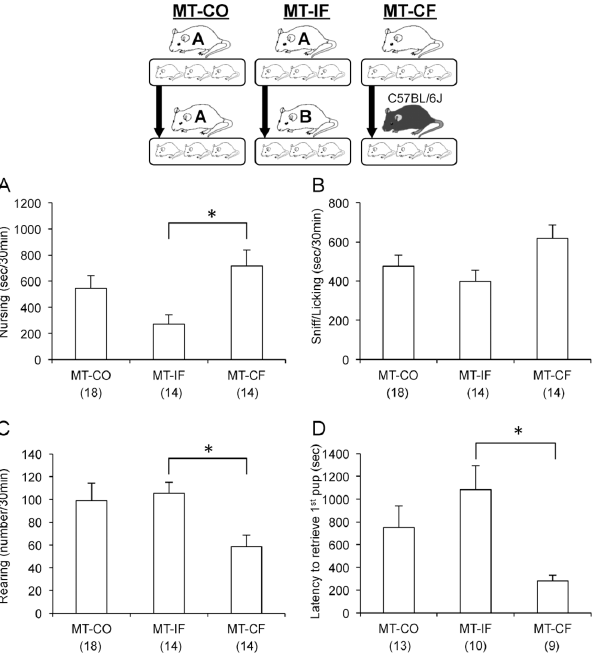
Fig 5. Fostering effects on maternal behavior in MT mice. MT-CF showed significant improvements in time spent nursing, rearing and latency to retrieve 1 st pup. The number of mice used is shown within parentheses. * p < 0.05, one-way ANOVA with Tukey ’ s post hoc